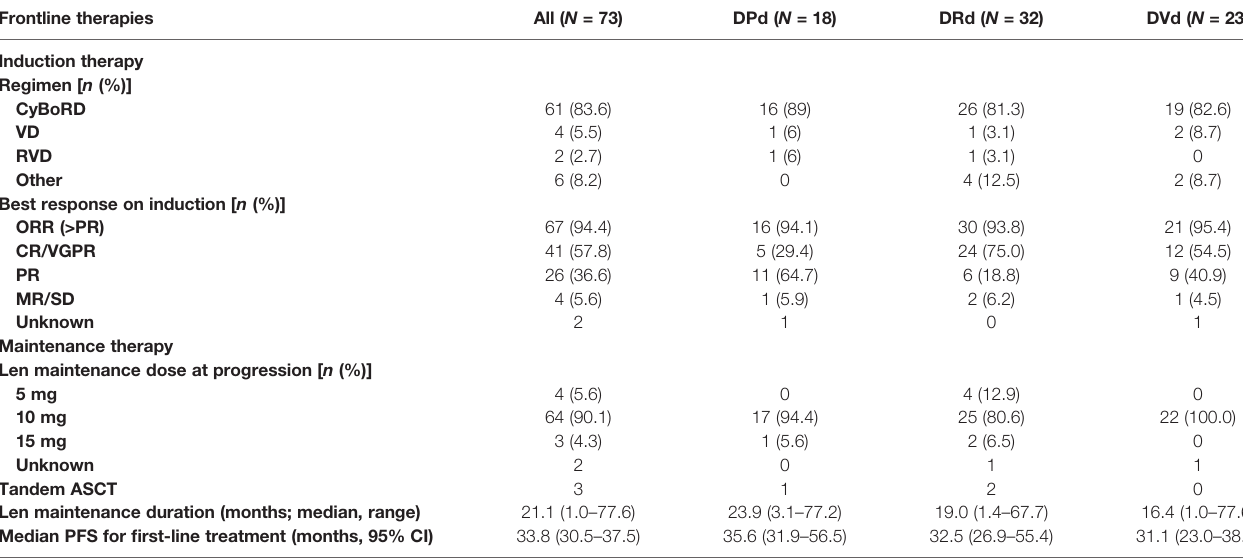
TABLE 2 | Summary of frontline therapy for the daratumumab combination treatment groups. Frontline therapies